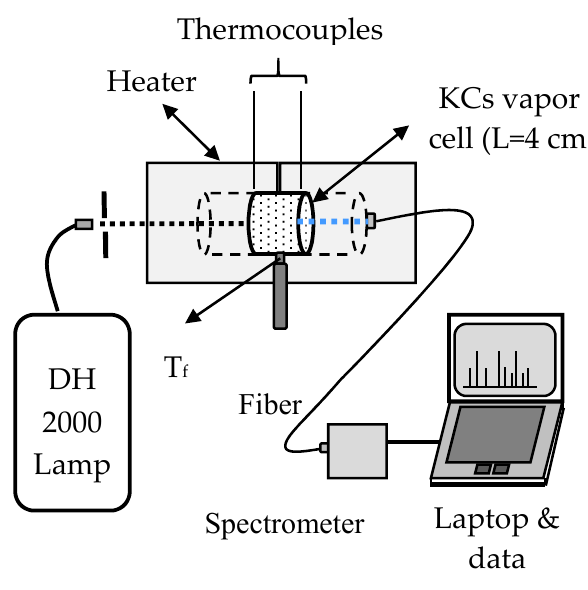
Figure 1. Experimental setup.